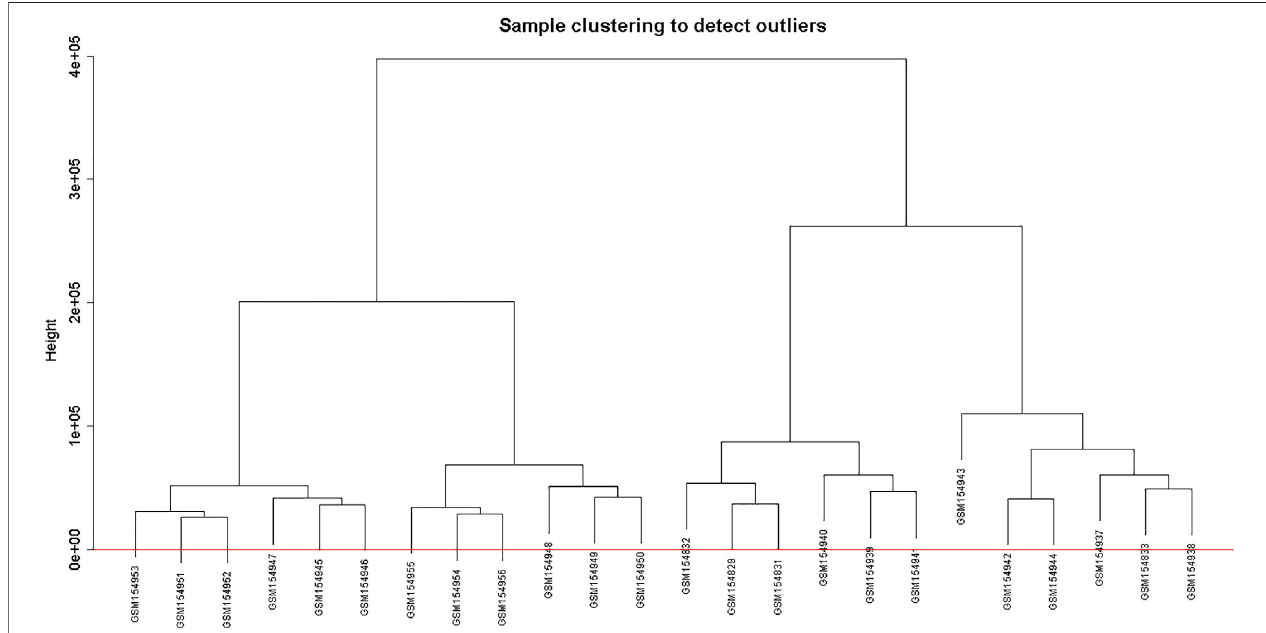
FIGURE 1 | Clustering dendrogram of samples based on their Euclidean distance.